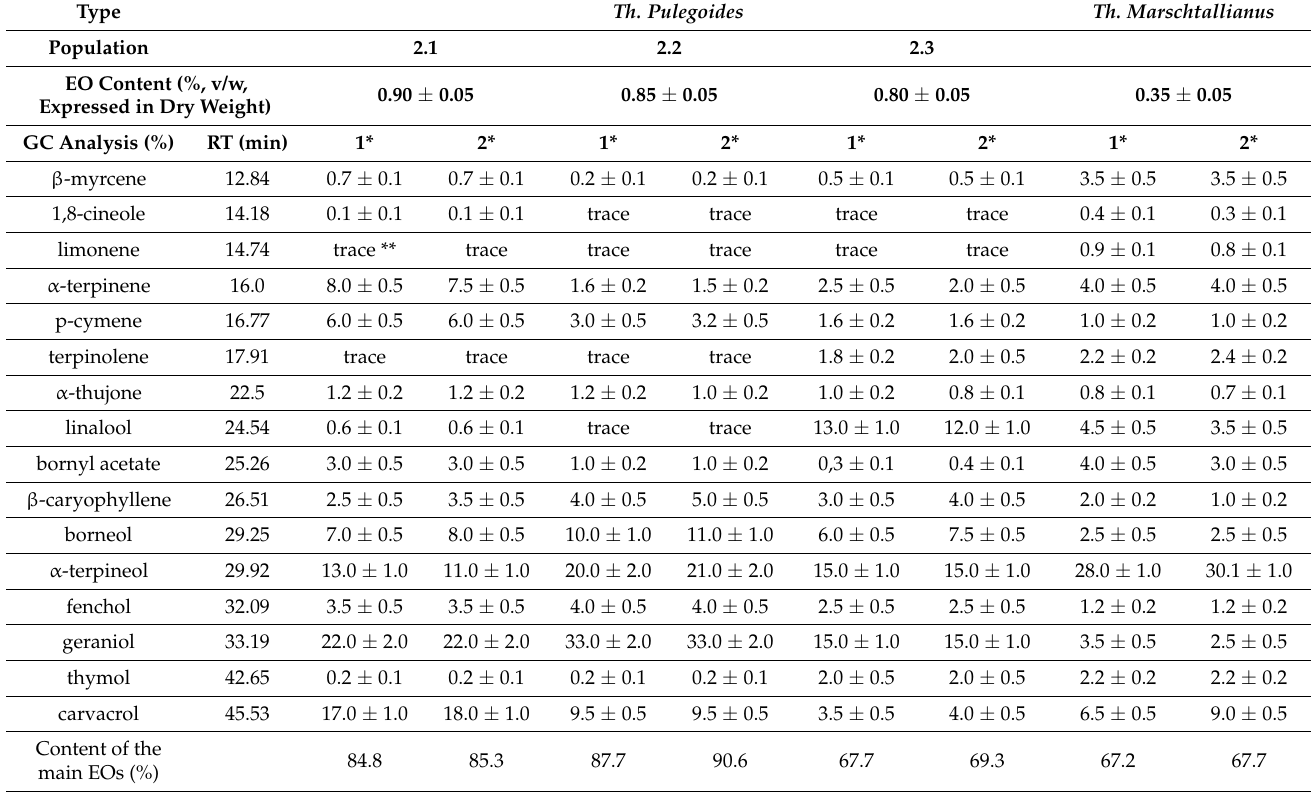
Table 2. The component composition of Thymus essential oils from different places of growth plant species (x ±